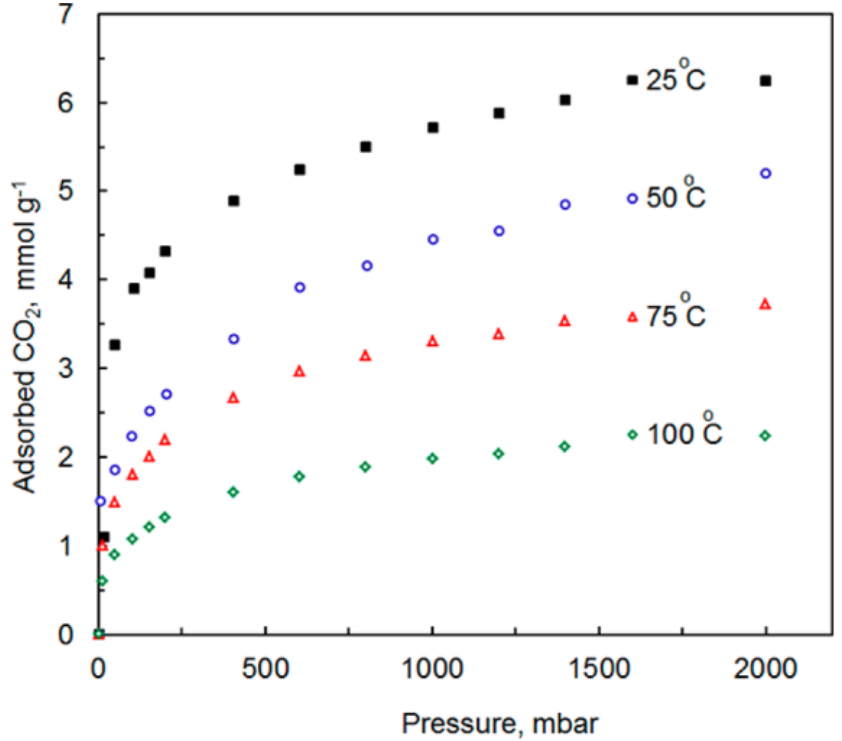
Figure 43. Breakthrough curves of MMT-CA-1 at increasing temperatures (reproduced from the work in [37] with permission).